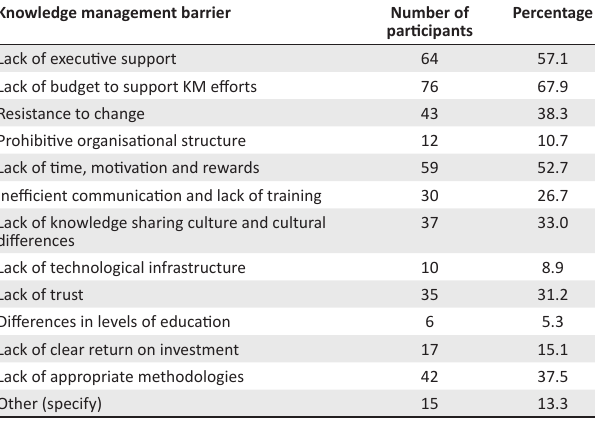
TABLE 2: Analysis of the knowledge management barriers. Knowledge management